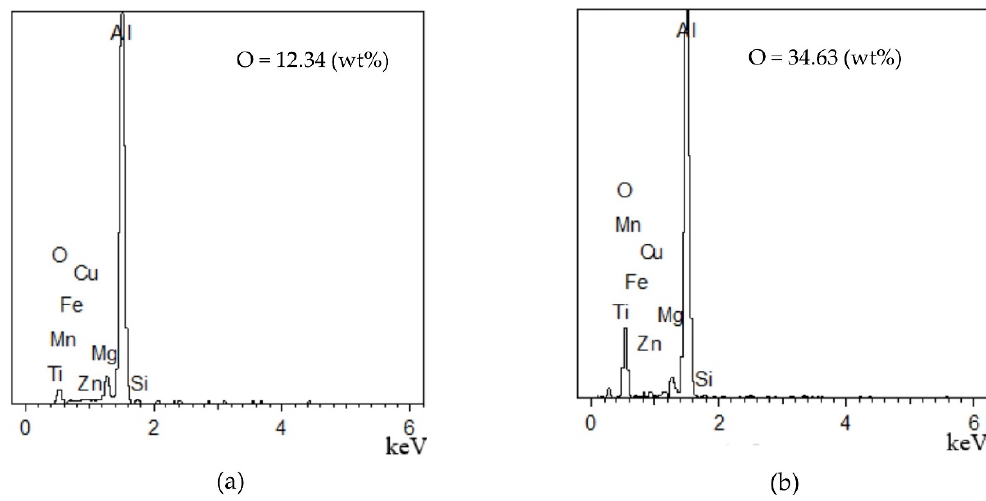
Figure 7. Energy-dispersive X-ray spectrometer (EDS) result; ( a ) untreated chip; ( b ) 500 °C thermally-treated chip.